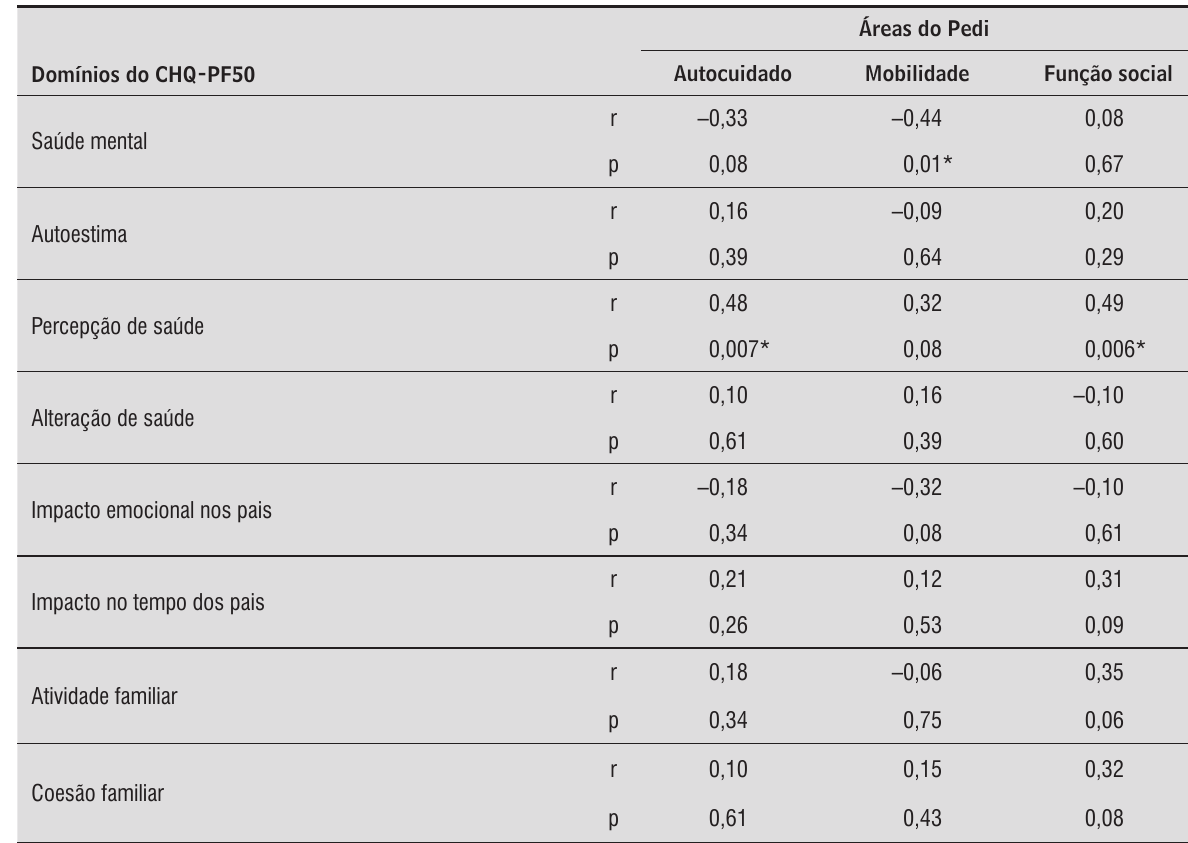
Legenda: * = correlação signi fi cativa entre as variáveis; p < 0,05. Fonte: Dados da